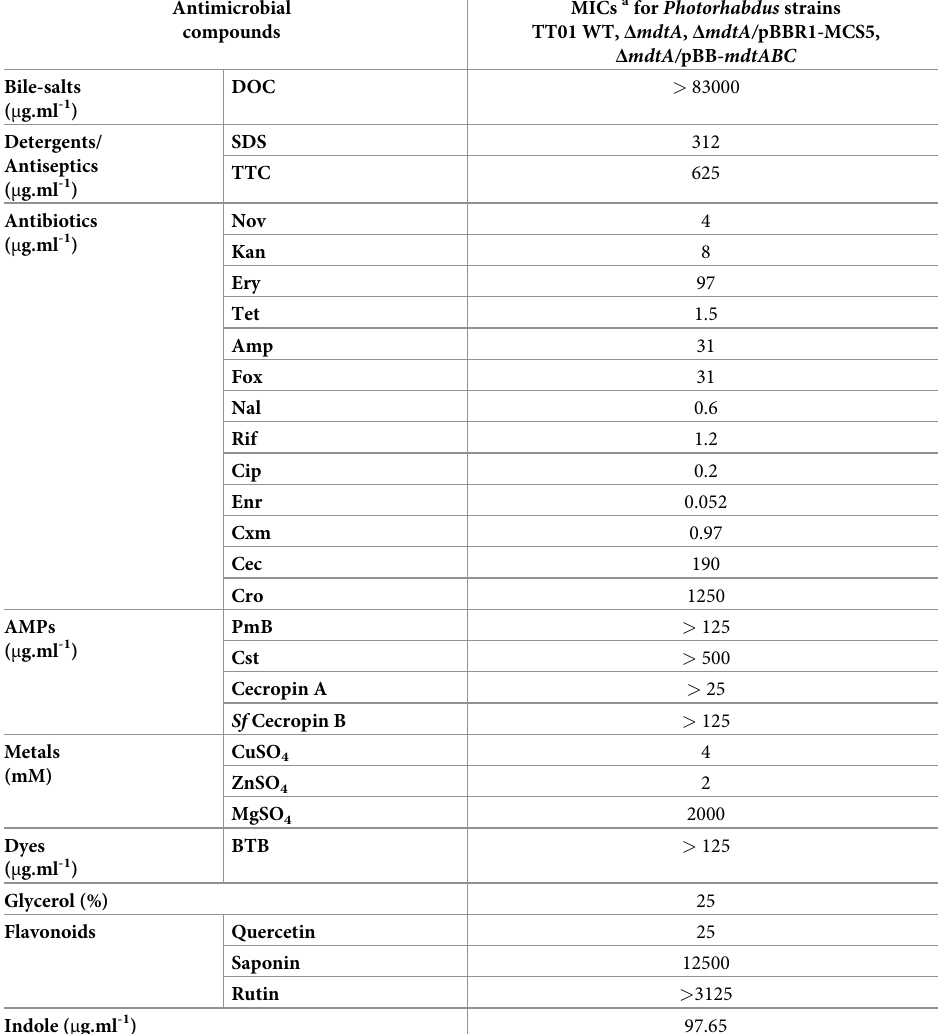
Table 2. Minimum growth-inhibitory concentrations (MICs) a of various antimicrobial and toxic compounds for wild-type P . luminescens TT01 (TT01 WT), the Δ mdtA mutant and its derivatives harbouring pBBR1-MCS5 or pBB -mdtABC